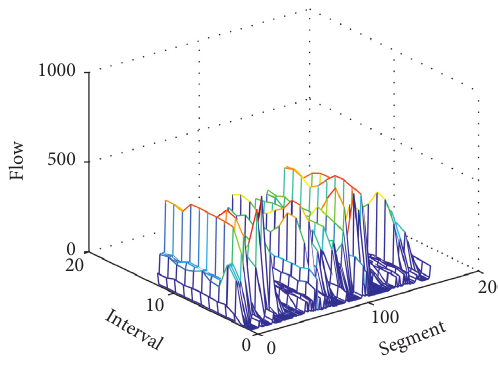
Figure 11: The averaged flow with